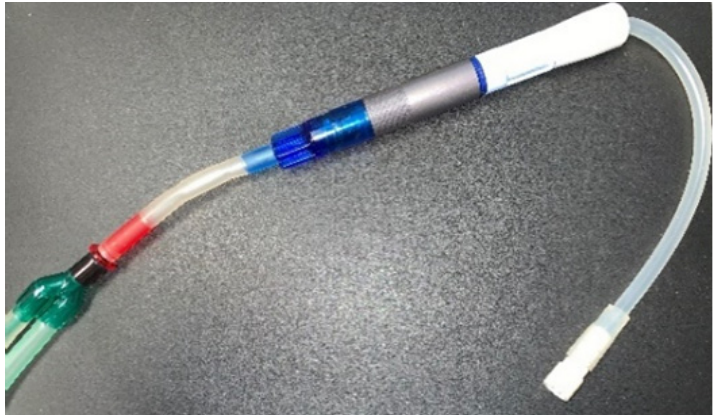
Figure 9. PB connector link manufactured in titanium with equipment from both brands.